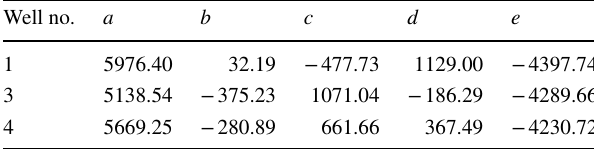
Table 5 Specifications of the three productive wells in the field Property